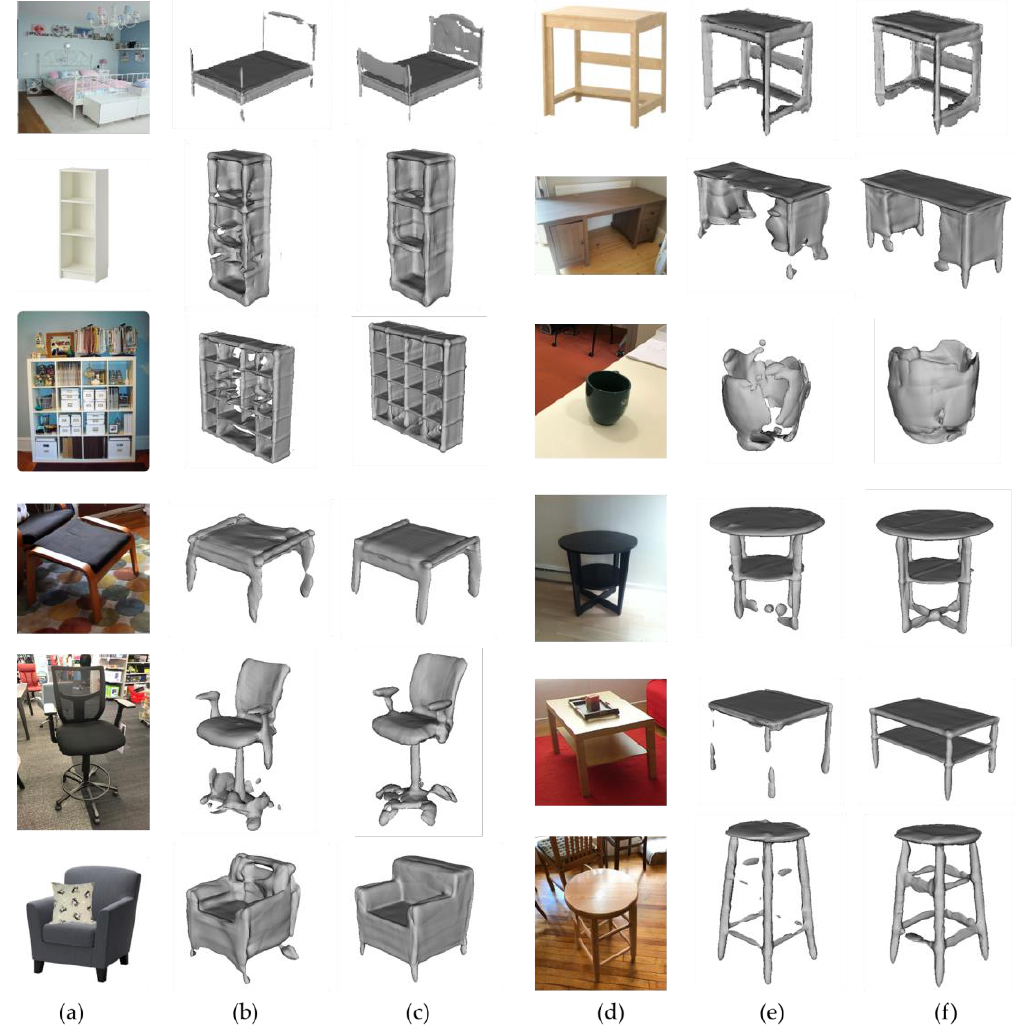
Figure 6. Mesh reconstruction results for the Pix3D dataset. ( a , d ) input images; ( b , e ) rendered images of reconstructed meshes produced using Implicit3D; ( c , f ) rendered images of reconstructed meshes produced using the proposed method.